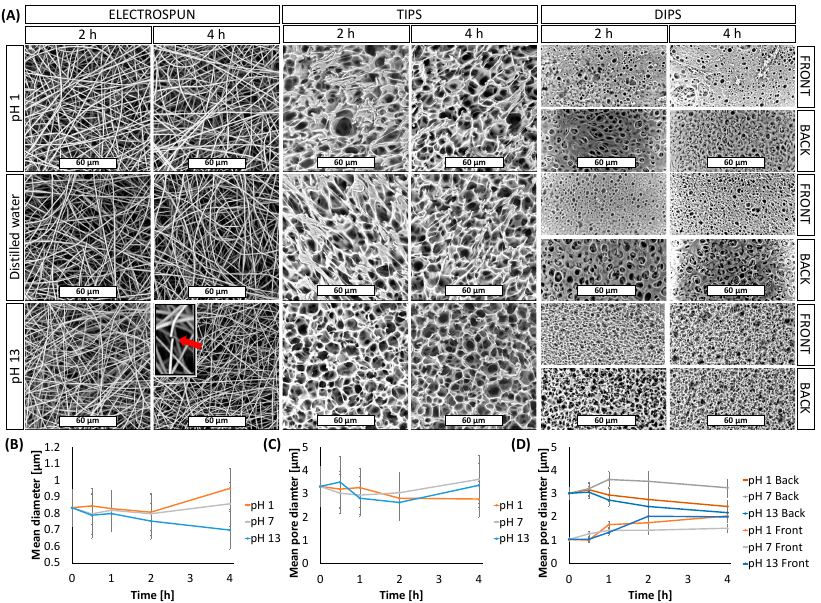
Figure 2. ( A ) SEM images of membranes immersed for 2 h and 4 h in different medium as a function of pH; ( B ) Mean fiber diameter of ES membranes as a function of time and pH; Mean pore diameter of ( C ) TIPS and ( D ) DIPS membranes as a function of time and pH.